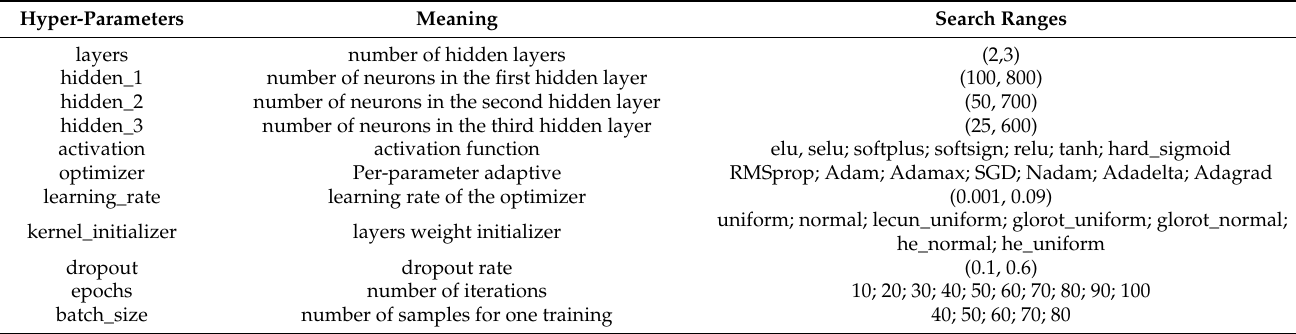
Table 3. The ranges of hyper-parameters that need to be adjusted.